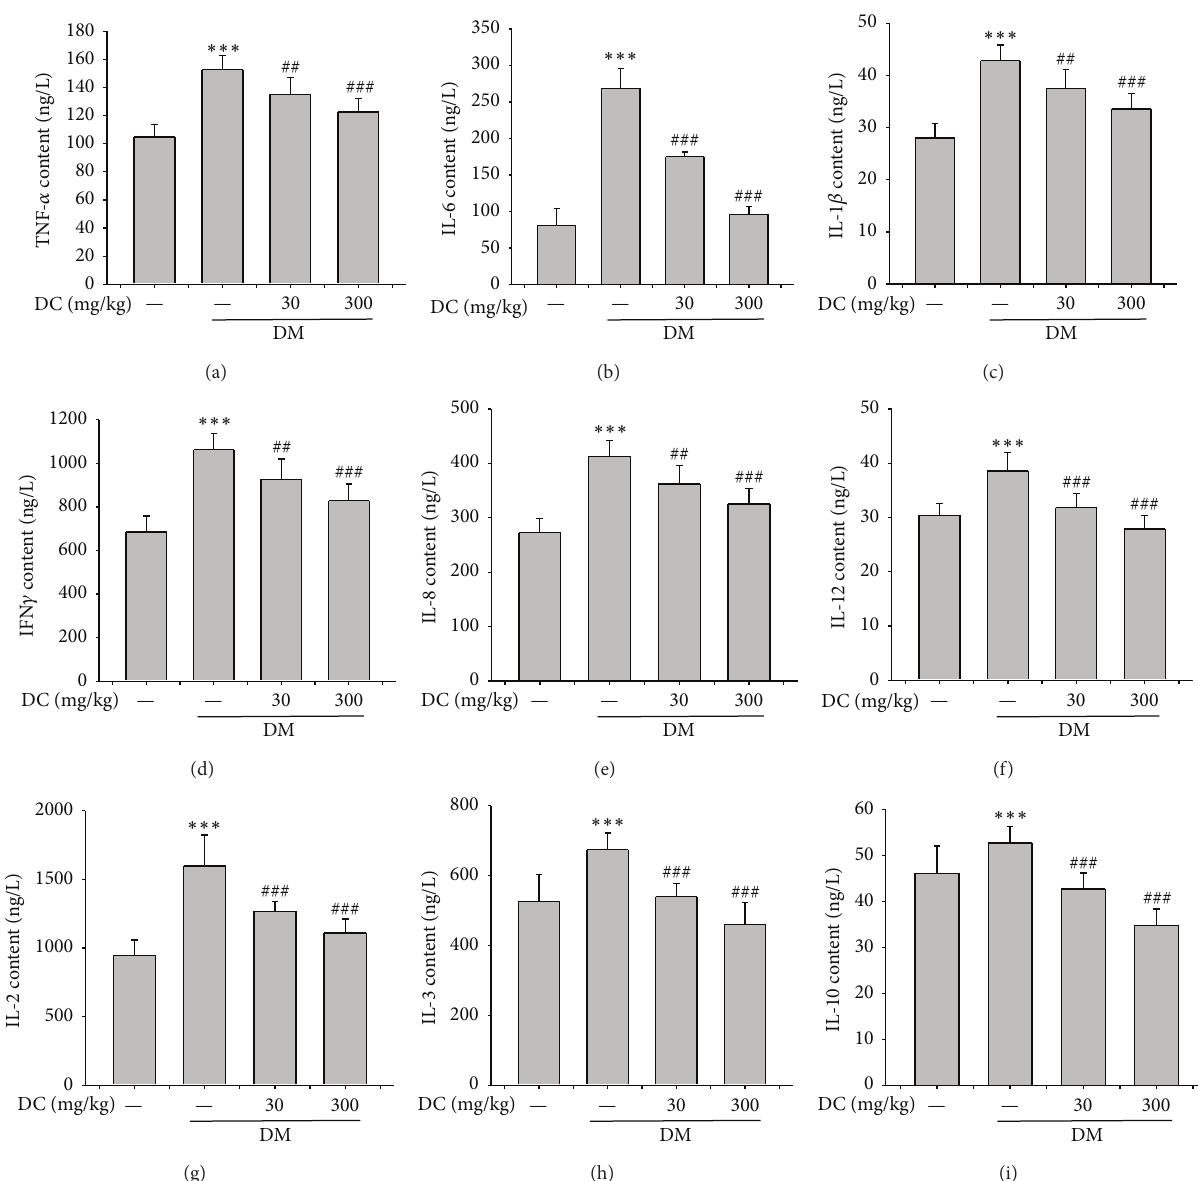
Figure 5: Serum levels of various cytokines. (a) TNF 𝛼 , (b) IL-6, (c) IL-1 𝛽 , (d) IFN 𝛾 , (e) IL-8, (f) IL-12, (g) IL-2, (h) IL-3, and (i) IL-10. Data are expressed as means ± SD ( 𝑛 = 10 for control, 𝑛 = 7 for DM, 𝑛 = 9 for DM+DC 30 mg/kg, and 𝑛 = 8 for DM+DC 300 mg/kg). ∗∗∗ 𝑃 < 0.001 compared to control; ## 𝑃 < 0.01 , # 𝑃 < 0.05 compared to DM without DC.